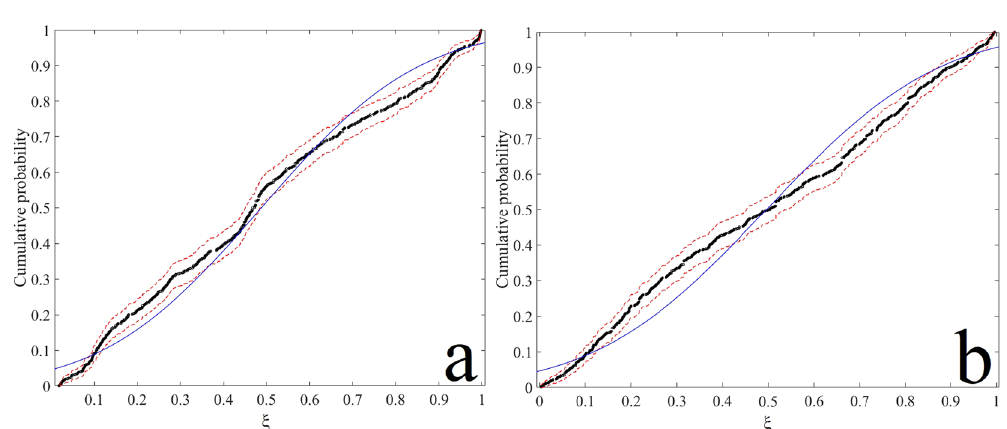
Figure 7. Cumulative probabilities of ( a ) measurements water level (dots black) ( b ) results of the free oscillations obtained by the HAMSOM model (dots black). The line (blue) is the theoretical prediction and the dashed lines (red) are the 90% confidence limits.